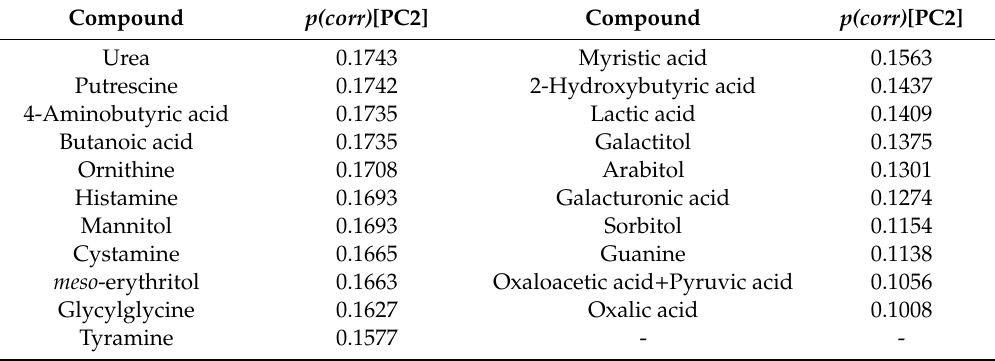
Characteristic hydrophilic low-molecular-weight compounds in broad-bean-based soy-sauce-like seasoning on